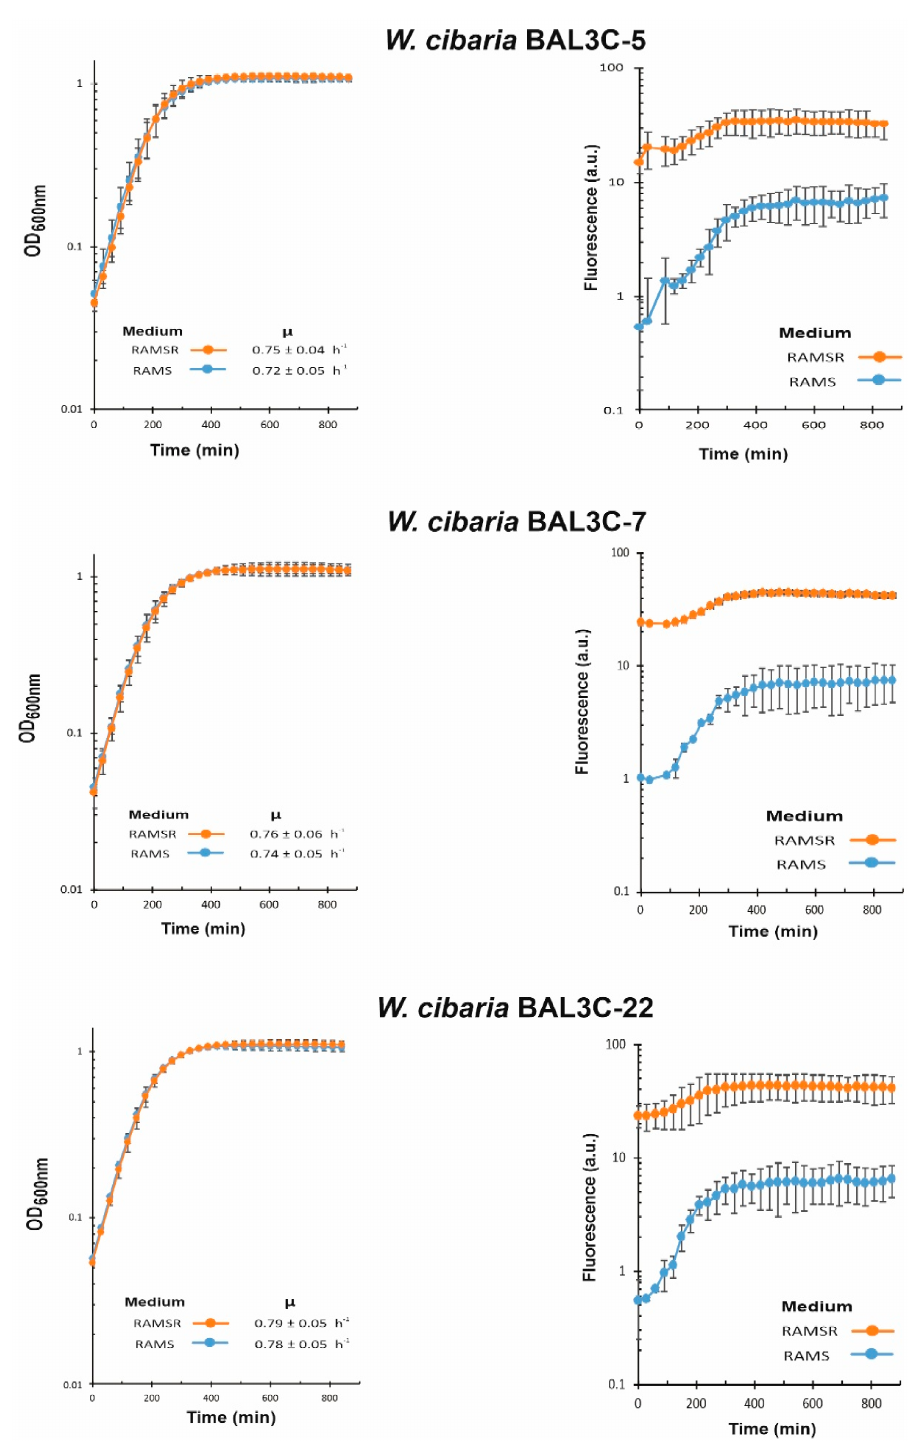
Figure 6. Detection of riboflavin production by the W. cibaria strains. A comparative analysis in real time of lactic acid bacteria cultures grown in RAM medium supplemented with either 2% sucrose (RAMS) or 2% sucrose plus 2% riboflavin (RAMSR) is depicted. Left panels show the growth and growth rate of the cultures during the exponential phase. Right panels show the detection of riboflavin